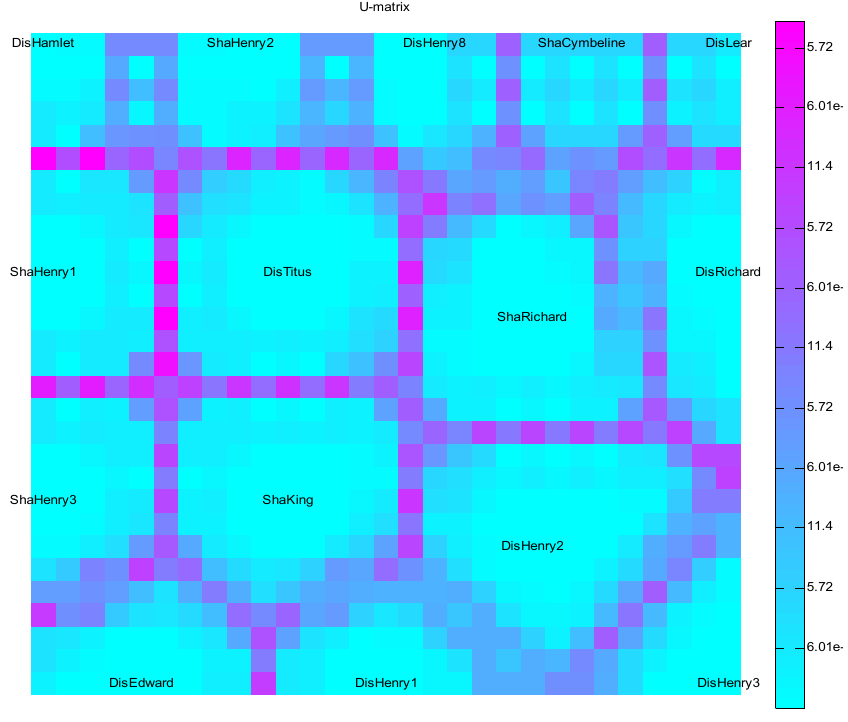
Figure 8. SOM U-matrix of Shakespeare D FW .